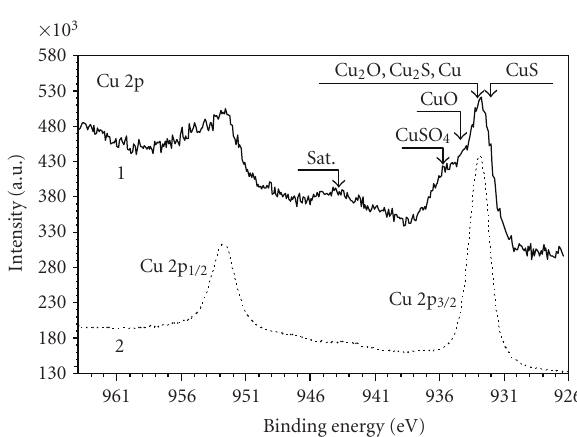
Figure 2: Copper XPS Cu 2p spectra of PA 6 sulfured for 5 hours and treated with Cu(I) salt: (1) before and (2) after Ar + cleaning. Arrows show possible positions of copper peaks as described in the text.